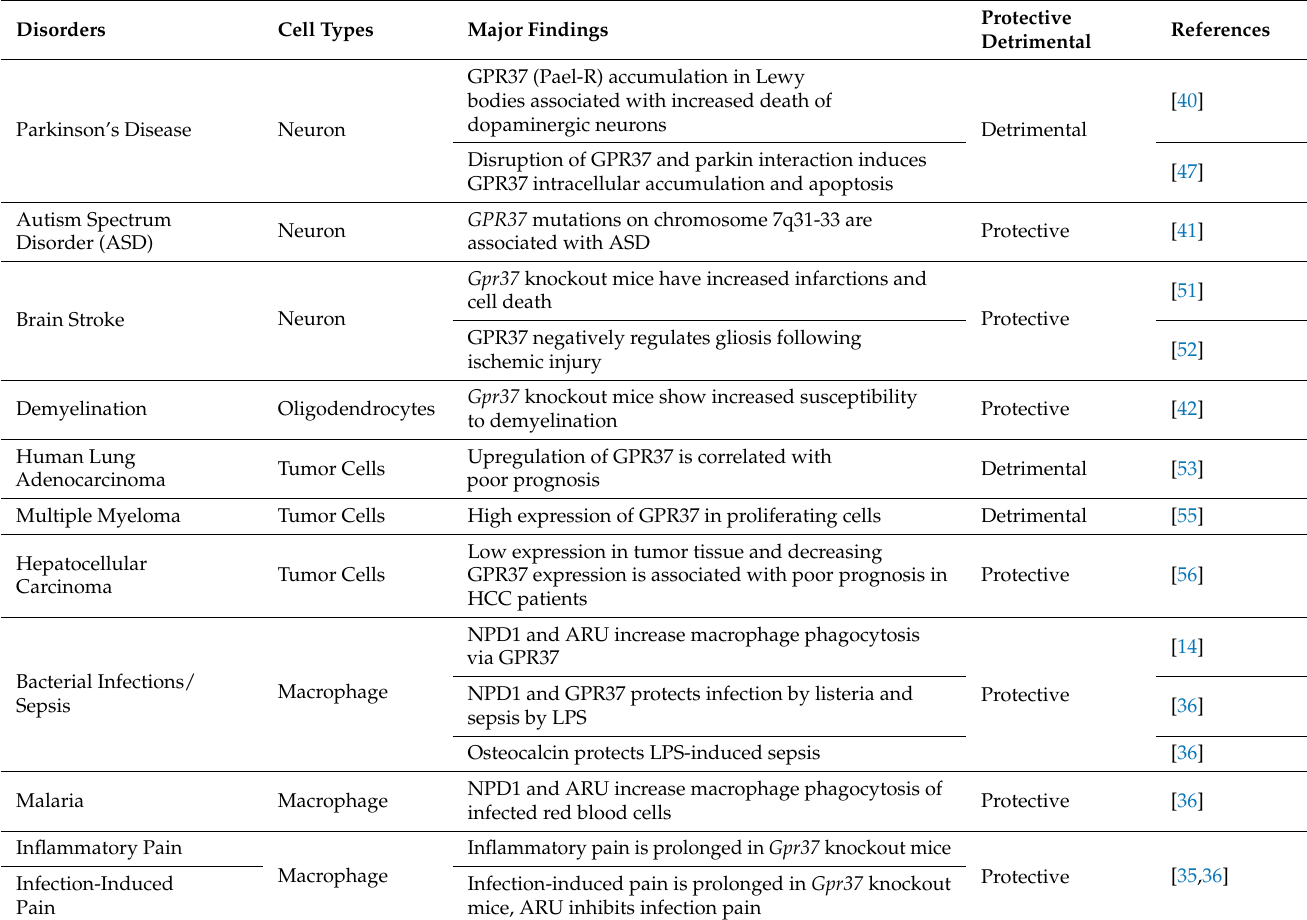
Table 1. Beneficial and detrimental roles of GPR37 in different disease